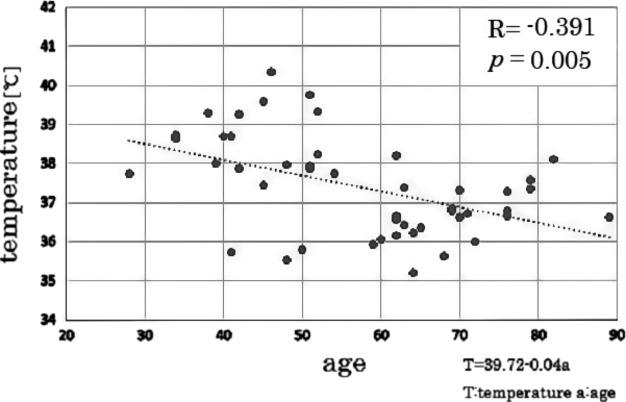
Correlation between age and ventricular CSF temperature in male controls. The dotted line indicates the result of linear fitting. Ventricular CSF temperature tends to decrease by age with a significant correlation controlling for ventricular volume.